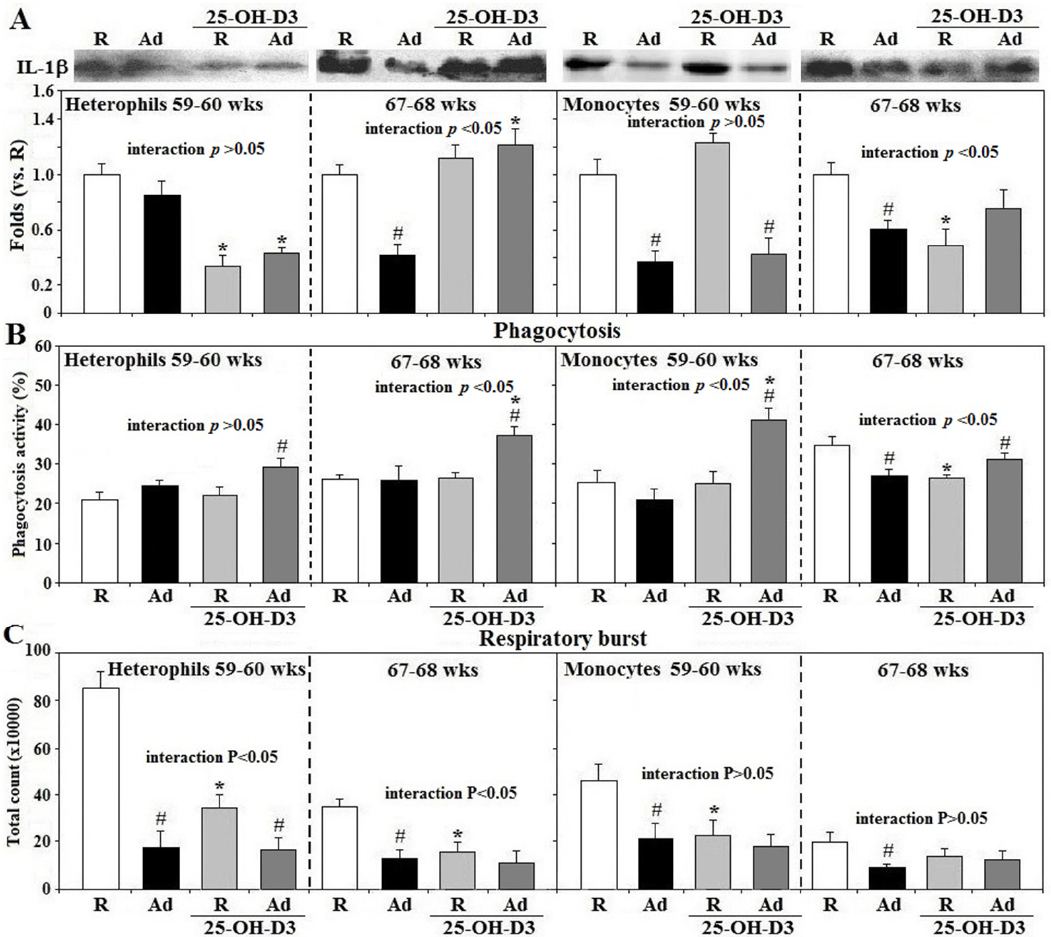
Figure 2. Effects of dietary supplementation of 25-OH-D 3 on IL-1 β secretion, phagocytosis, and the respiratory burst of leukocytes in broiler breeder hens provided with restricted (R) or ad libitum (Ad) feed intake. Peripheral leukocytes (2 × 10 6 cells) isolated from hens at age 59–60 and 67–68 weeks (wks) were cultured for 3 h and medium were then collected for interleukin-1 β (IL-1 β ) analysis ( A ) by Western blot method based on equivalent amounts of protein ( n = 6). Freshly prepared cells were used for phagocytosis analysis ( B ) and respiratory burst analysis ( C ) ( n = 6). Chemiluminescence results of respiratory burst analysis were expressed as integrated counts over 45 min. Results of Western blots were expressed as rations relative to R-hens. *; significant difference by 25-OH-D 3 , p < 0.05, #; significant difference by Ad-feed intake. 25-OH-D 3 ;